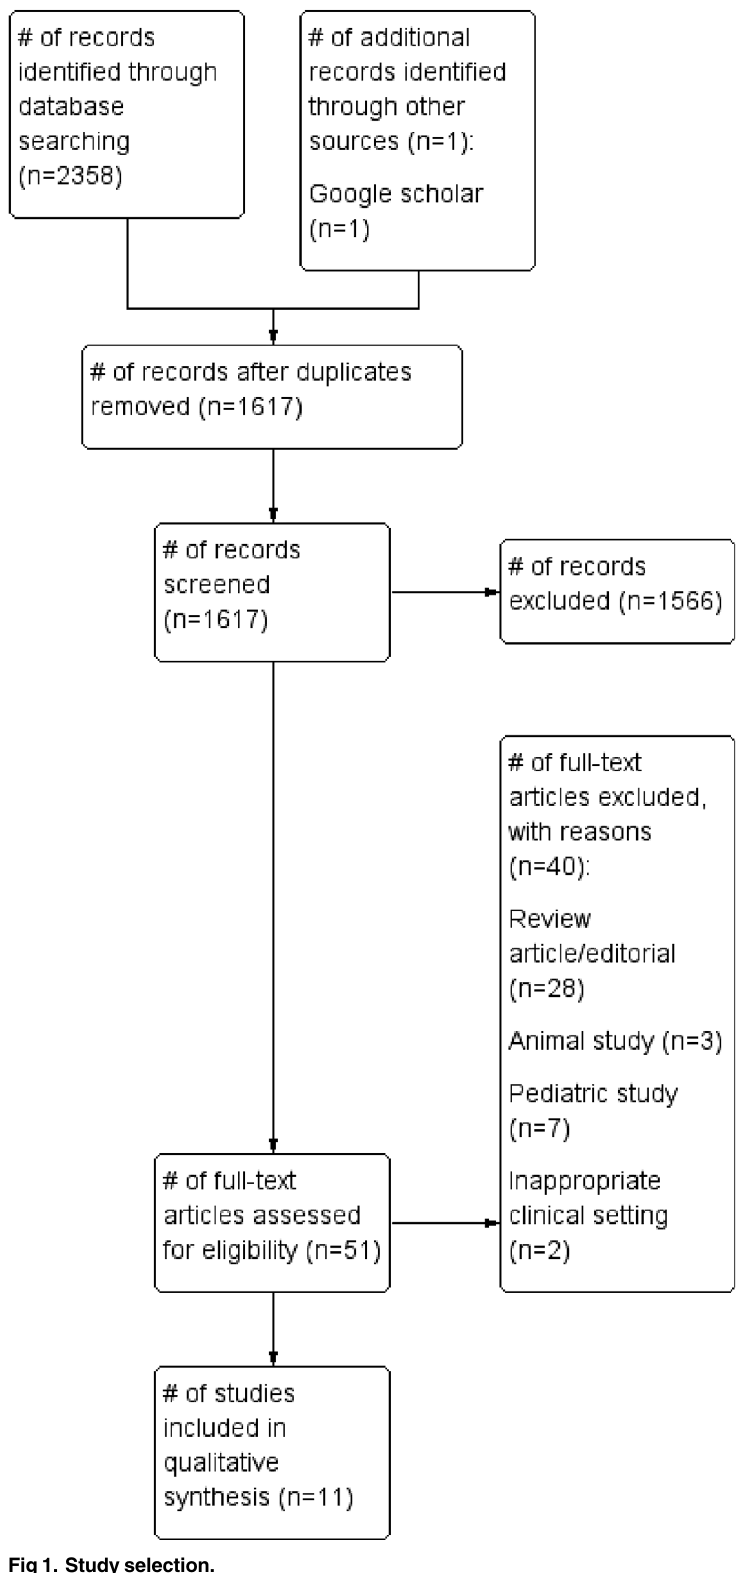
Fig 1. Study selection.